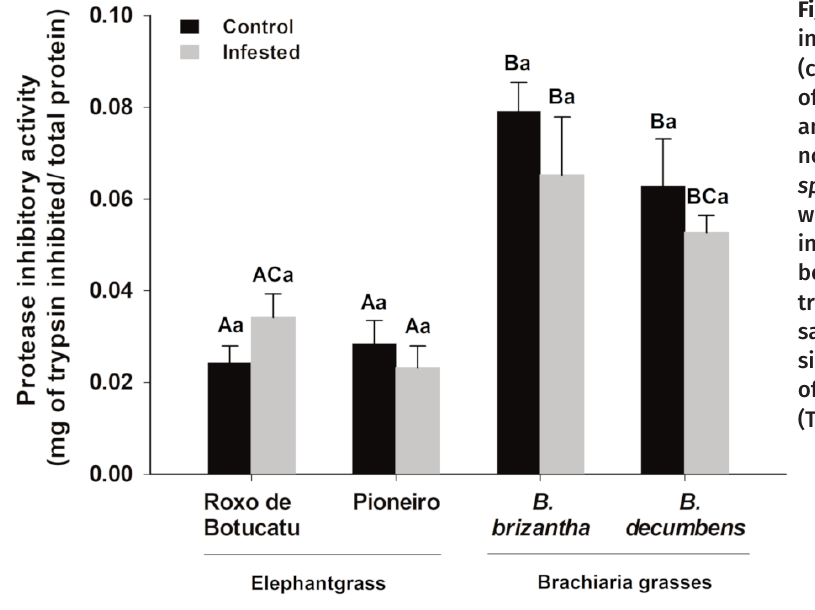
Figure 3. Protease inhibitory activity in leaves of different forage grasses (cvs. Roxo de Botucatu and Pioneiro of elephant grass, B. brizantha , and B. decumbens ) infested or not (control) with Mahanarva spectabilis . Bars (mean ± SE; n = 4) with the same lowercase letters indicate no significant difference between the control of infested treatments. Those followed by the same capital letters indicate no significant difference among forage of grasses within same treatment (Tukey’s test: P <